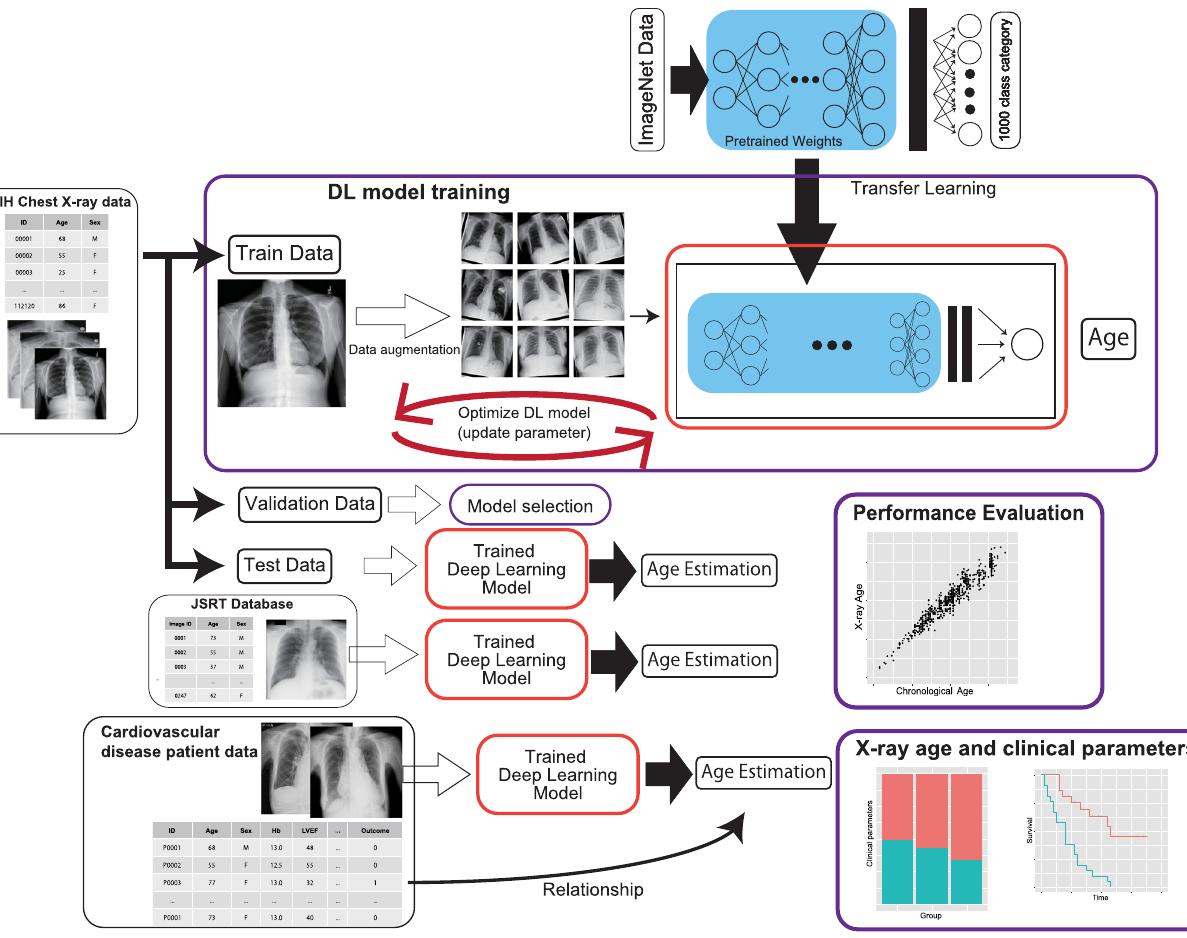
Fig. 1 Data usage and overall study framework. The NIH Chest X-ray dataset was randomly divided into training, validation and test datasets. Our deep neural network (DNN) models were trained to estimate the age using the training dataset. The weights of the models were initialized with pre-trained weights on ImageNet data and trained using transfer learning and fi ne-tuning techniques. Various models with different architectures were separately trained. Validation data were only used to tune the hyperparameters and to select the fi nal model. The accuracy of the deep learning model was estimated using a hold-out test dataset. The independent JSRT dataset was also used to estimate the performance to verify the generalizability of the trained DNN in an independent population. The trained DNN was applied to CXRs of heart failure patients to evaluate the association between the estimated age (X-ray age) and various clinical parameters and the clinical outcomes of heart